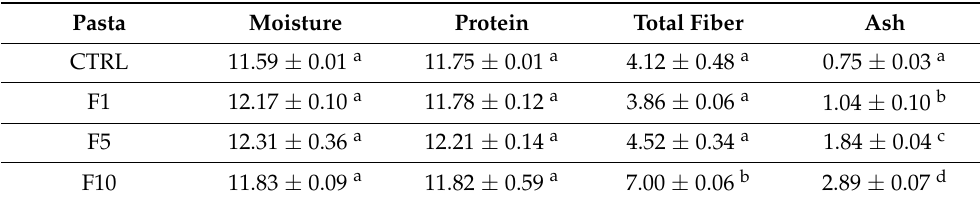
Table 1. Proximate composition of raw semolina pasta (CTRL) and pasta enriched with F. vesiculosus